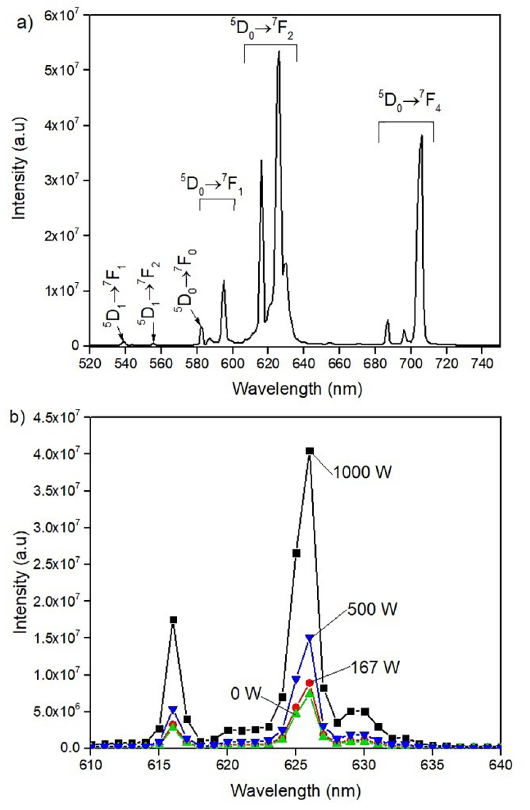
=325 nm) of the red- exc , 1 → 7 Fj 0